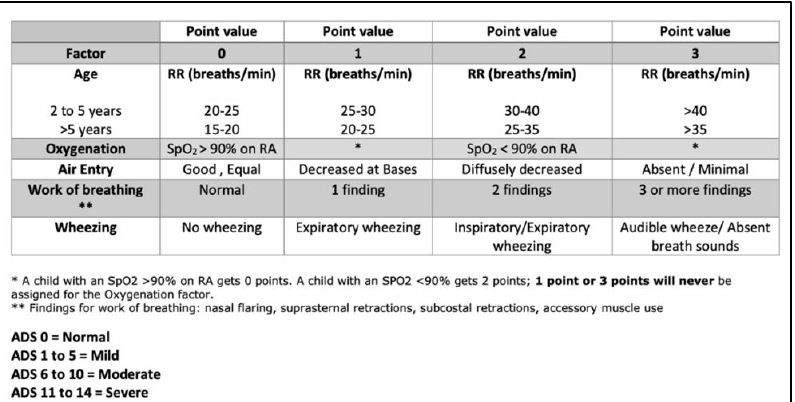
Figure A1. Asthma Distress Score. This is the criteria utilized by the respiratory therapy department at the UPMC Children’s Hospital of Pittsburgh [15].